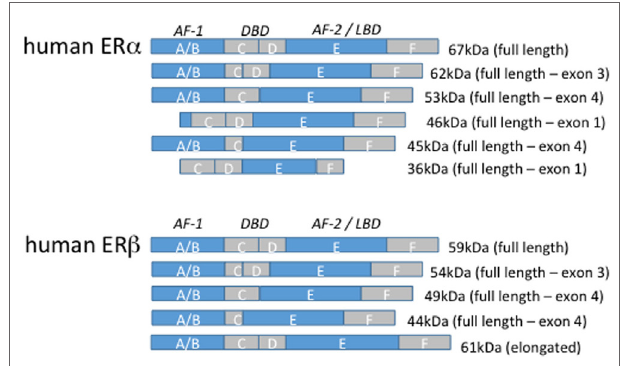
FiGURe 1 | estrogen receptor isoforms . The domain organization of human estrogen receptor α and β isoforms are illustrated above. The size of the full-length, truncated, and elongated isoforms is